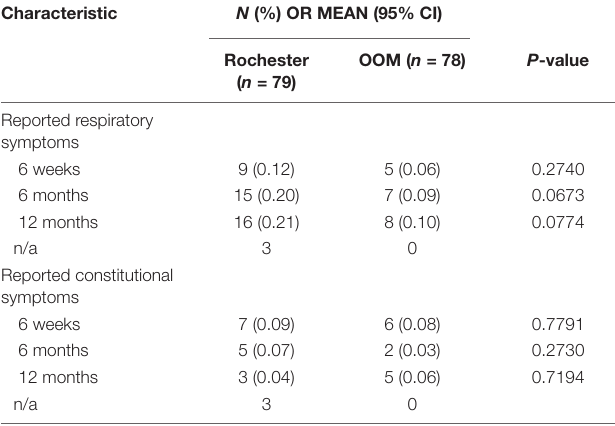
TABLE 4 | Infant demographics and exposures in the first year of